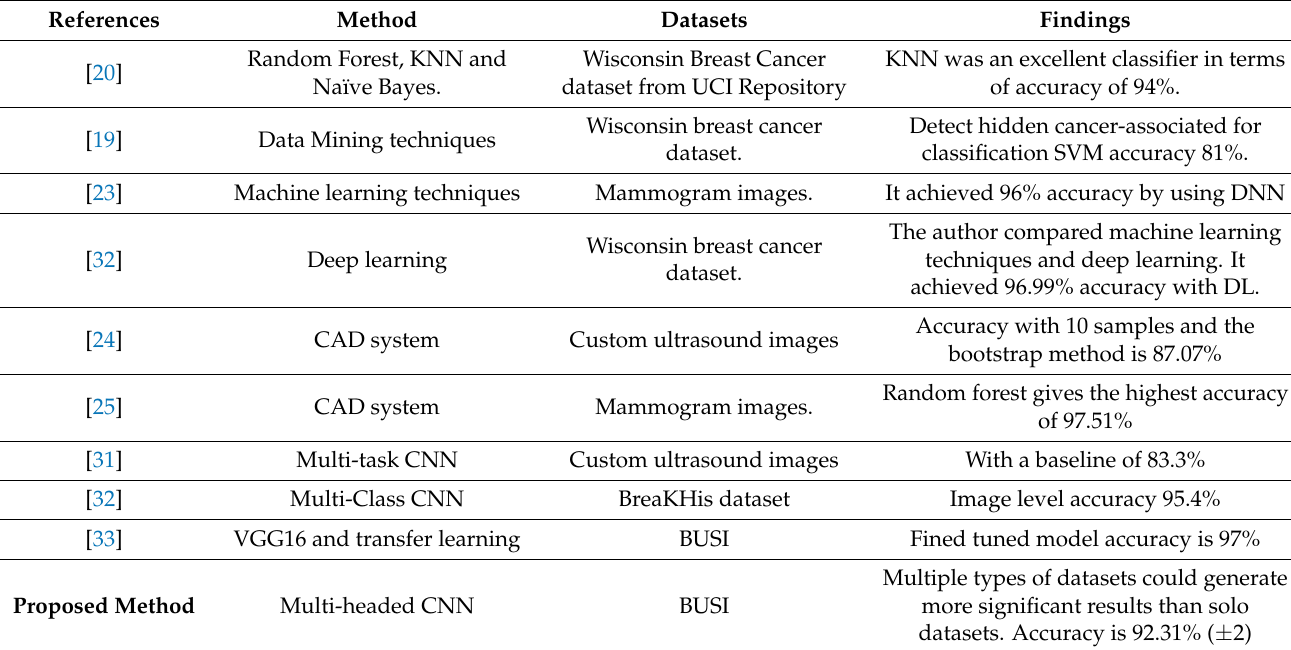
Table 6. Comparison of existing methods with their findings and